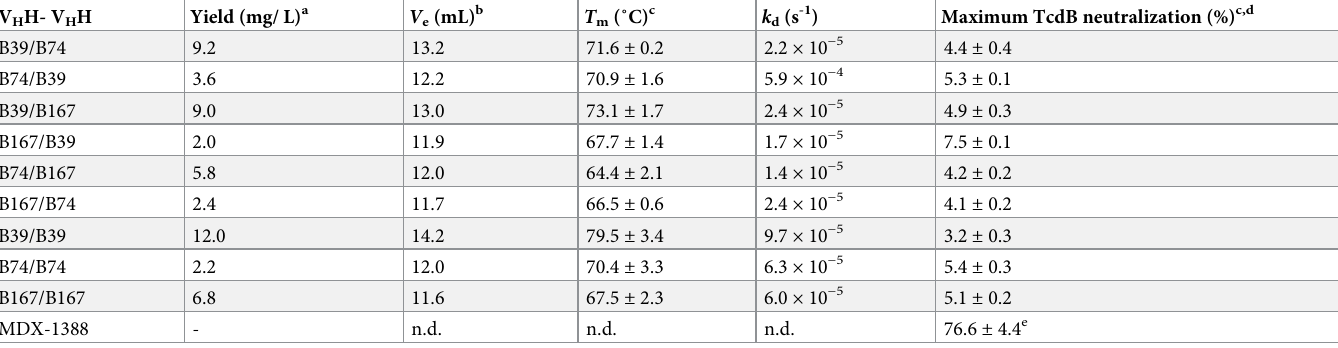
Table 2. Biophysical properties of anti-TcdB V H H-V H H dimers.